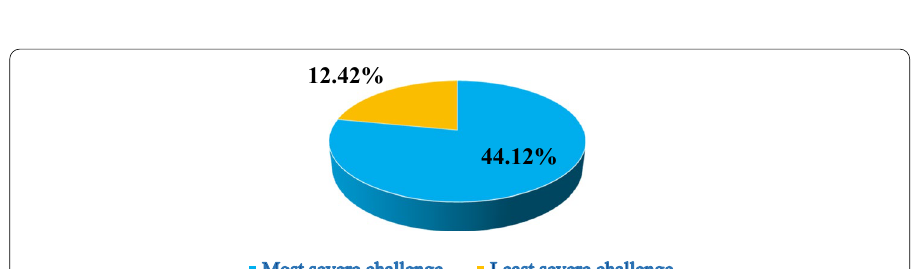
Fig. 17 Severity correlation of the second highest ranking